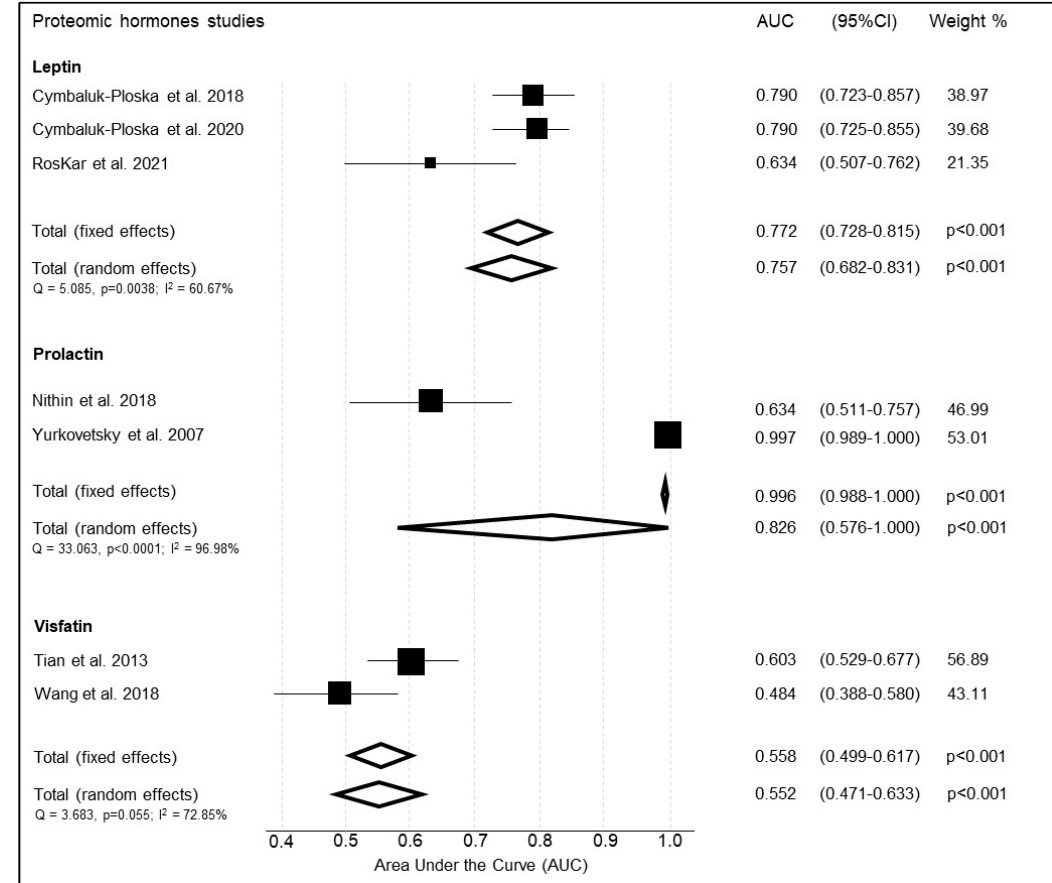
Figure 7. Summary of the diagnostic accuracy of proteomic hormones included in the meta-analysis.